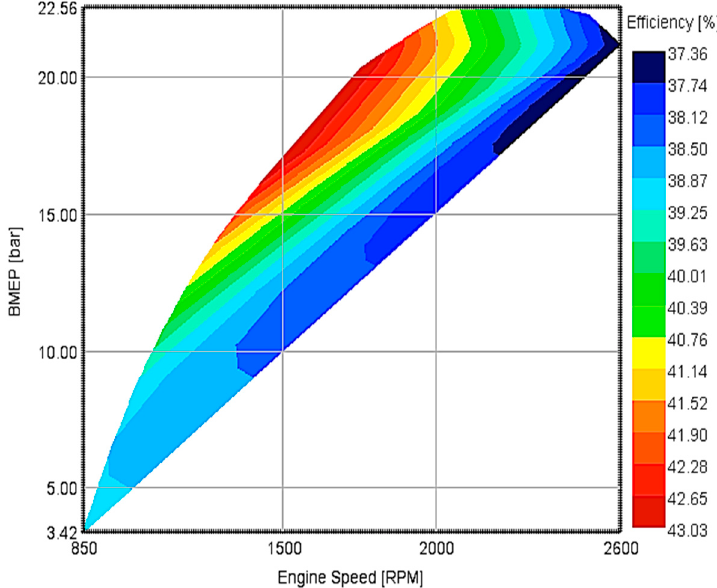
Figure 11. Variation of engine thermal efficiency in accordance with engines’ speed and BMEP.